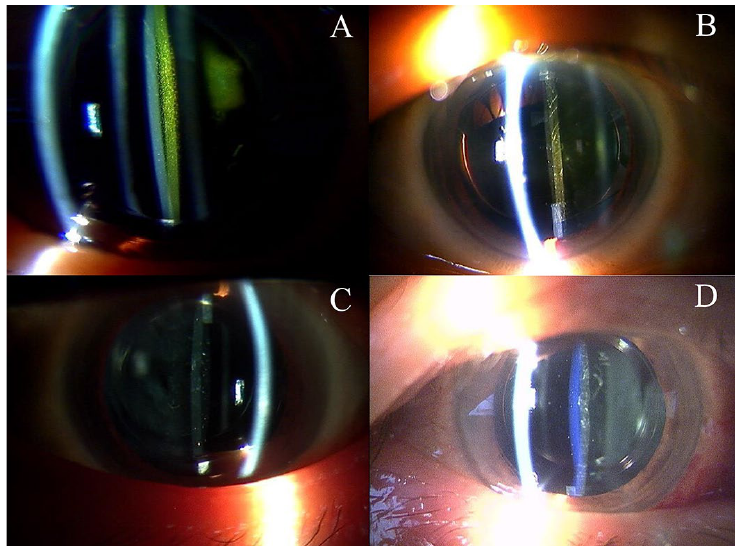
Figure 1. ( A ): Slit lump photograph of SN60WF J-code. ( B ): Slit lump photograph of SN60WF Q,A-code. ( C ): Slit lump photograph of ZCB00. ( D ): Slit lump photograph of ZCB00V.